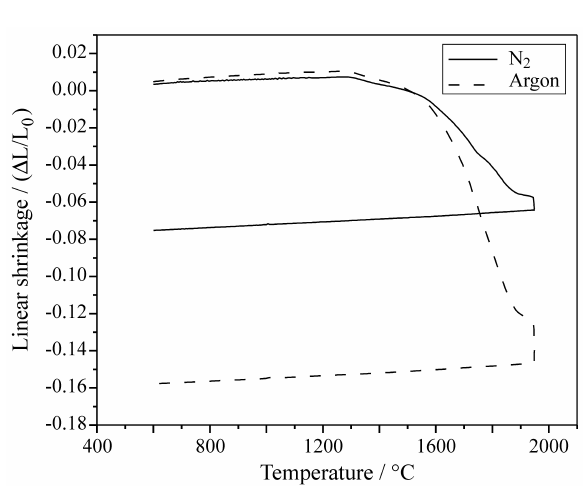
Fi gu re 4. 60-20Y Di la to me tric re sults: li ne ar shrin ka ge ver sus tem -